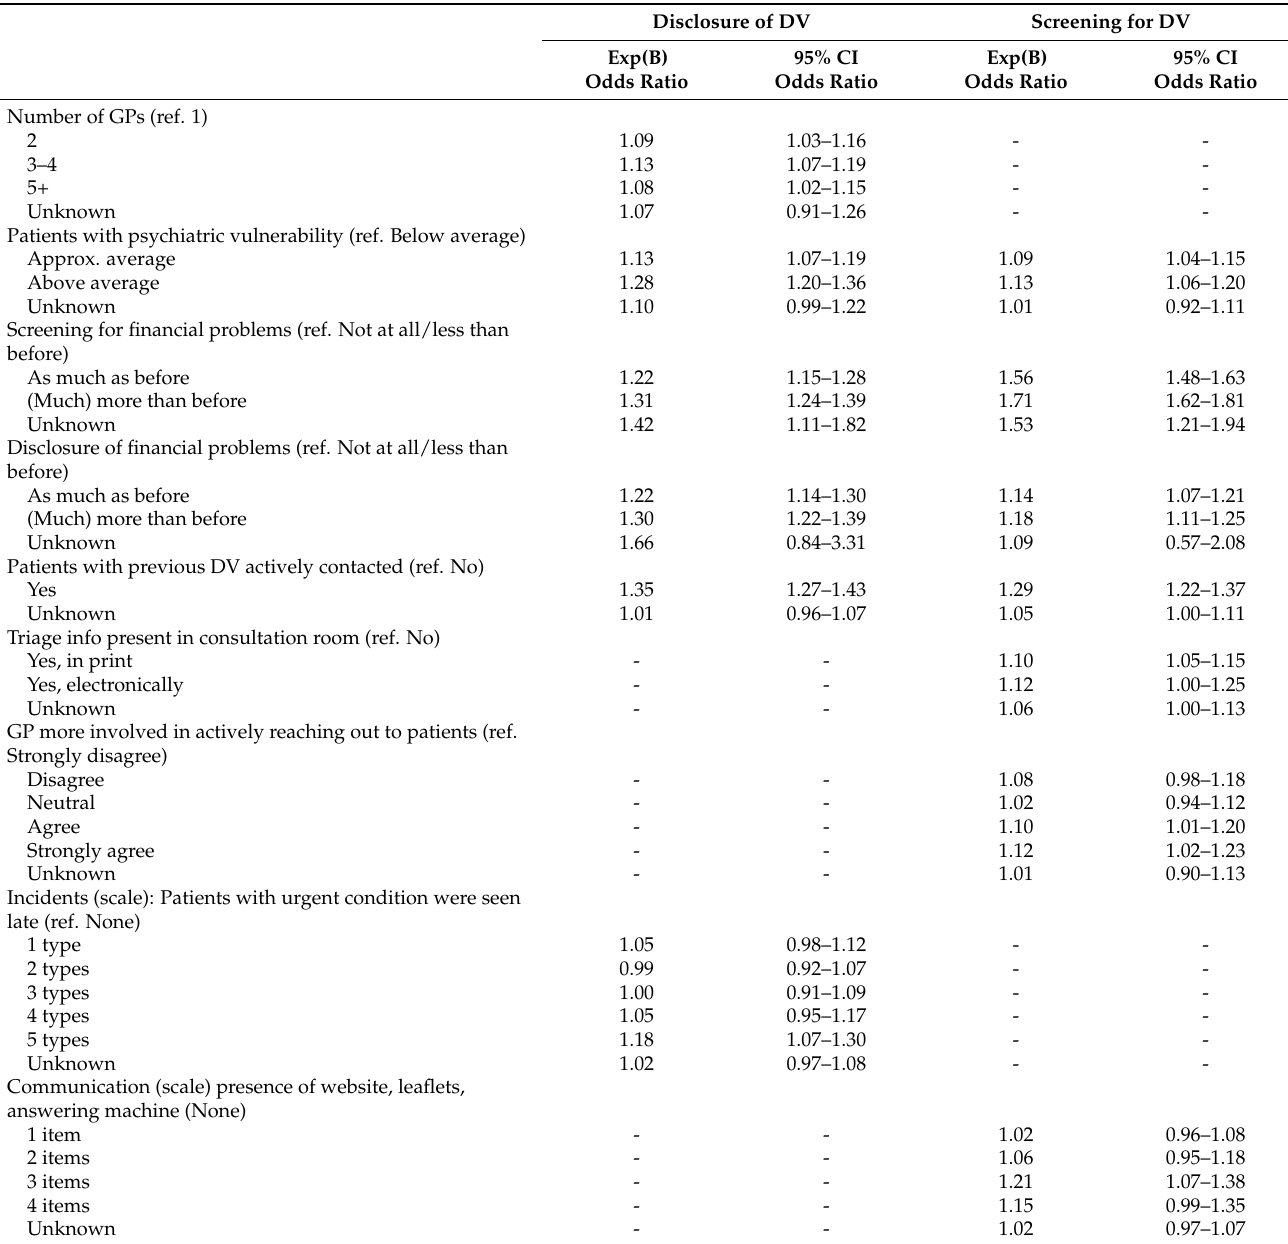
Table 2. Results of the mixed-model ordinal logistic regressions (Model V) of the factors related to disclosure of DV by the patient to the GP and screening for DV by the GP during the COVID-19 pandemic. Disclosure of DV Screening for